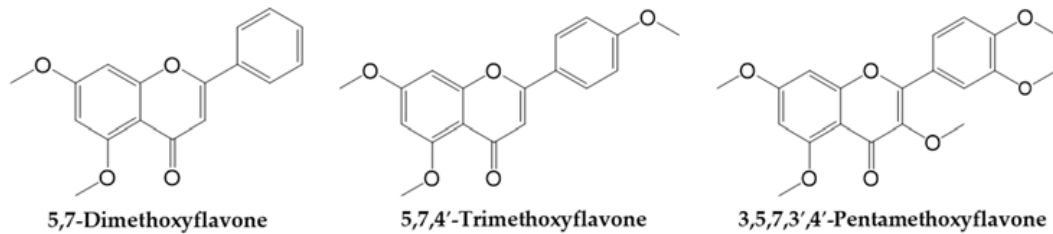
Figure 1. Chemical structure of polymethoxyflavones in Kaempferia parviflora (KP), including 5,7-Dimethoxyflavone ( DMF ), 5,7,4 (cid:48) -Trimethoxyflavone ( TMF ), and 3,5,7,3 (cid:48) ,4 (cid:48) -Pentamethoxyflavone ( PMF